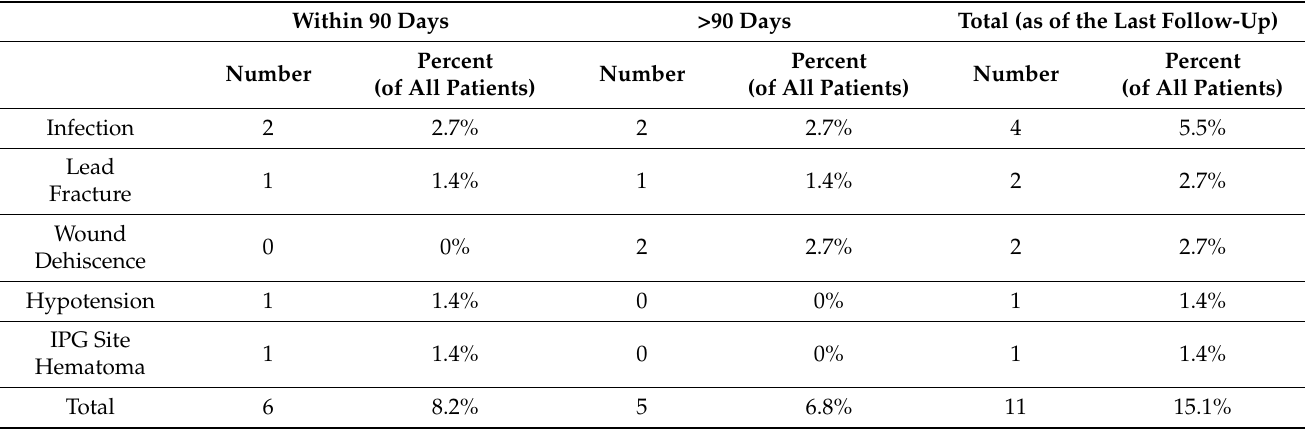
Table 1. Complications suffered by patients within 90 days of surgery and at 90 days or longer after surgery.